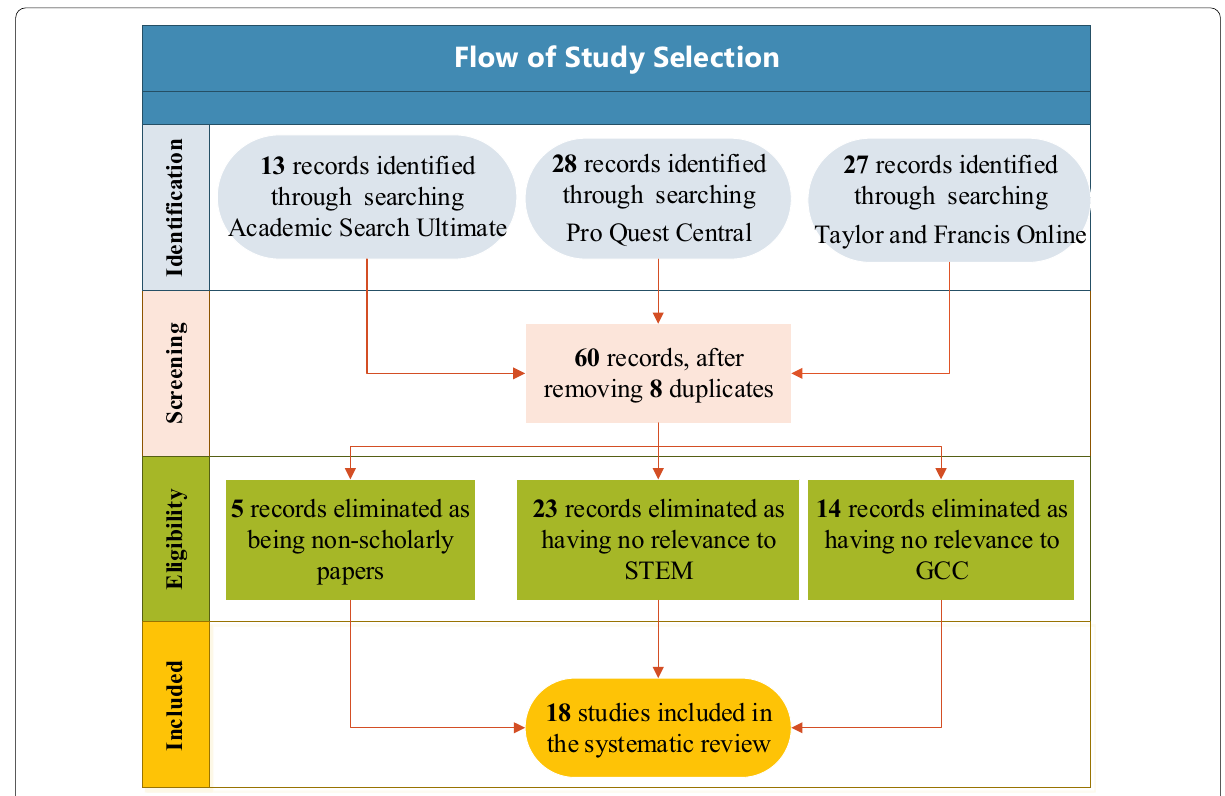
Fig. 8 Flow of the study